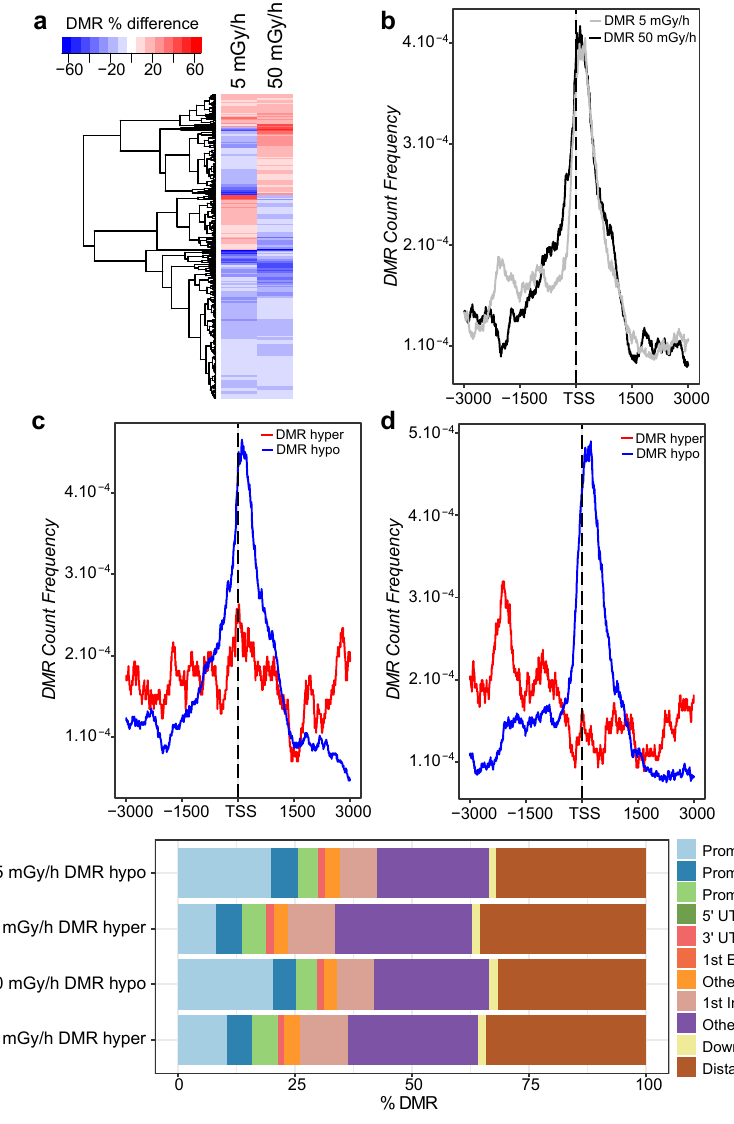
Figure 4. Analysis of di ff erentially methylated regions (DMR). ( a ) Heatmap of methylation di ff erence (%) in DMR detected at 5 and 50 mGy / h. Blue DMR: hypomethylation, red DMR: hypermethylation and white: no change. ( b ) DMR count frequency in a 6 kb window relative to known TSS (dashed line) at 50 mGy / h (black) and 5 mGy / h (grey). ( c ) Distribution of hypomethylated (blue) and hypermethylated (red) DMR in a 6 kb window centred to known TSS (dashed line) at 50 mGy / h and ( d ) at 5 mGy / h. ( e ) Distance of hypermethylated and hypomethylated DMR to known genomic features (TSS, gene promoter, exons, introns and intergenic